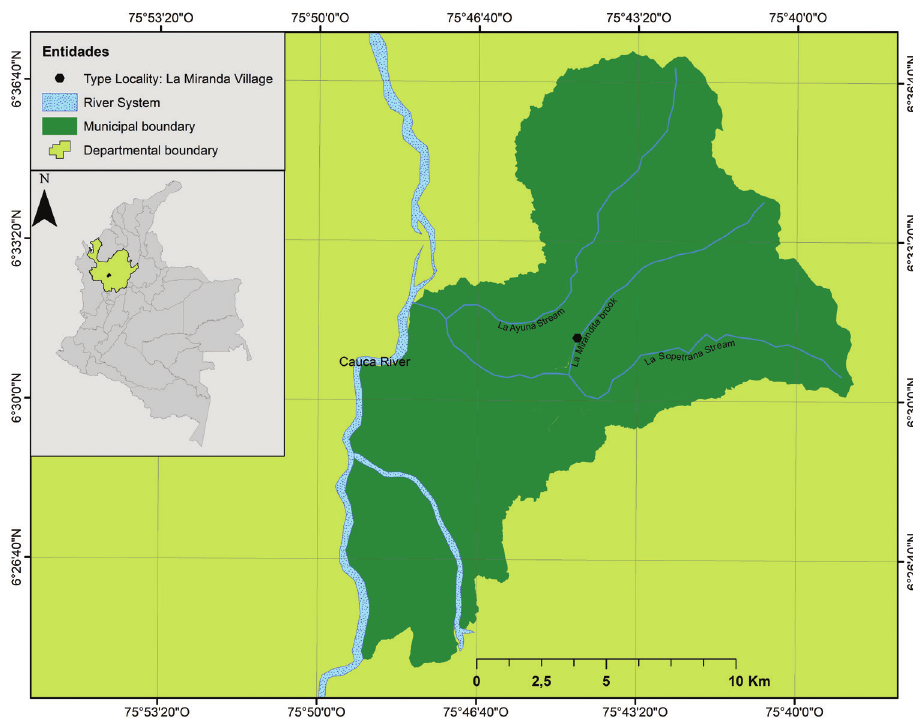
Figure 1. Type locality of the new species of Oligogonotylus from La Miranda village, Sopetrán, Antio- quia, Colombia. Map made in ArcGIS